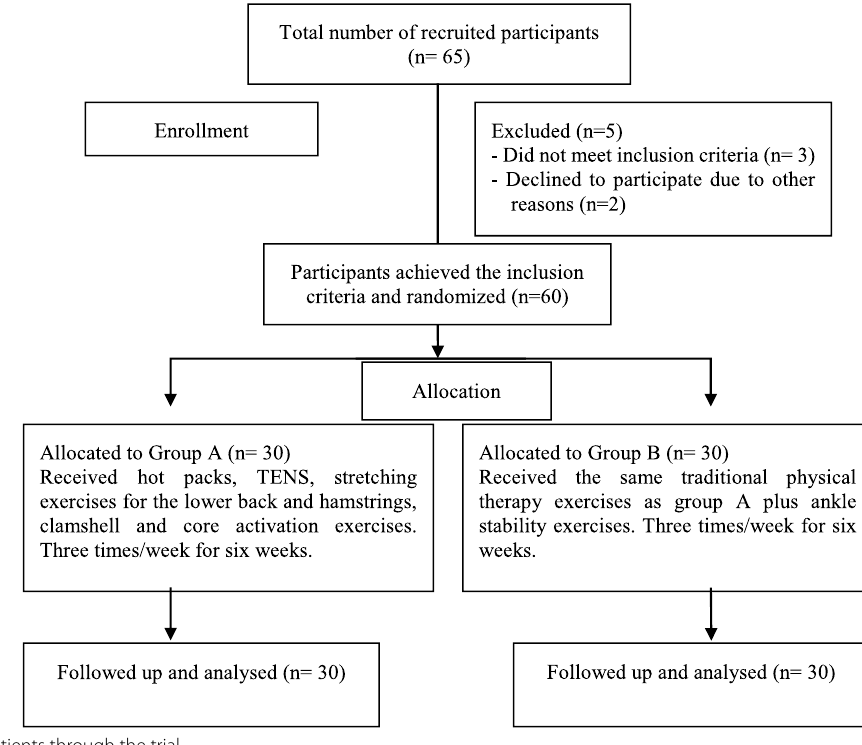
Fig. 1 Flow of patients through the